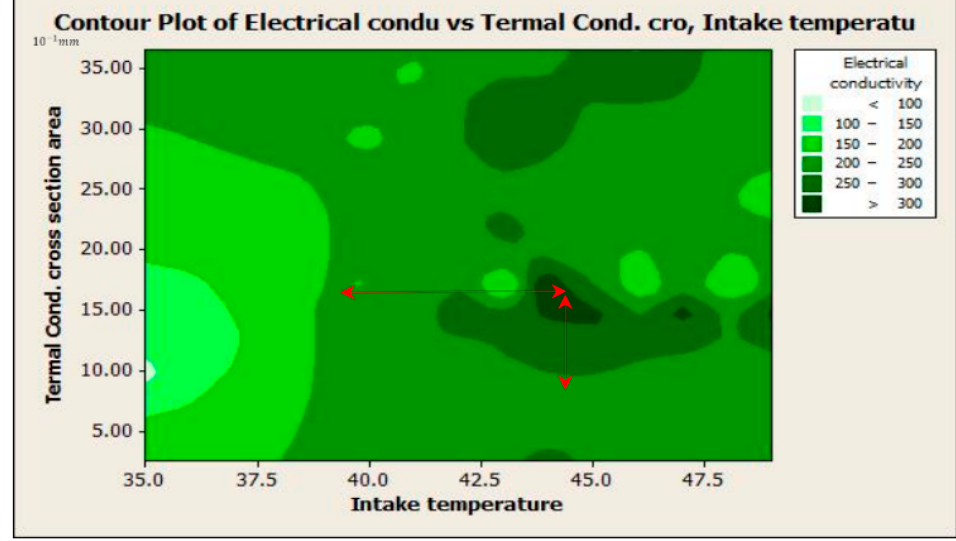
Figure 14. The strip cross section according to the intake affects the electrical conductivity at the highest available level. Hint: points to the preferred significant values.